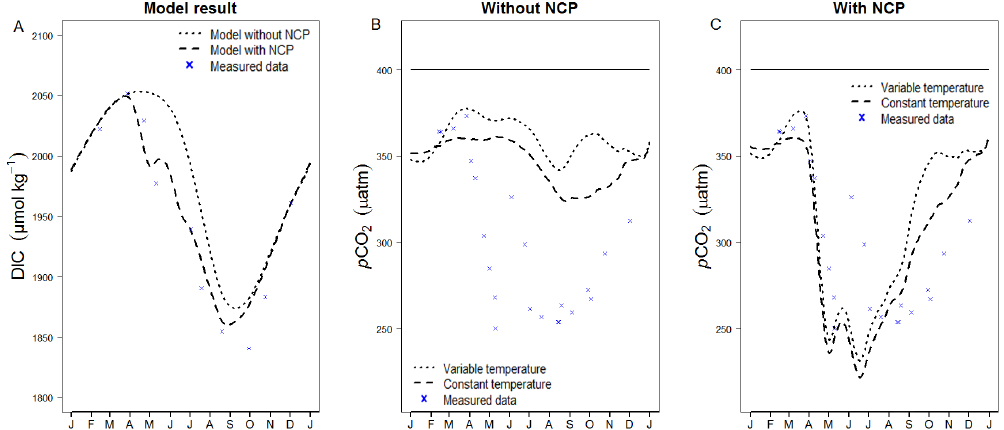
Figure 9. Seasonal evolution of DIC (in µmolkg − 1 ) (a) and p CO 2 (in µatm) ( b and c ) calculated by the biogeochemical model together with data from 2013 at station GF10 (blue points indicate measured data averaged over a 40m box). Simulations of the model are shown with and without net community production (NCP). Simulations of the evolution of p CO 2 are shown without (b) and with (c) NCP and for a variable temperature and constant temperature (0.5 ◦ C, the average winter temperature).